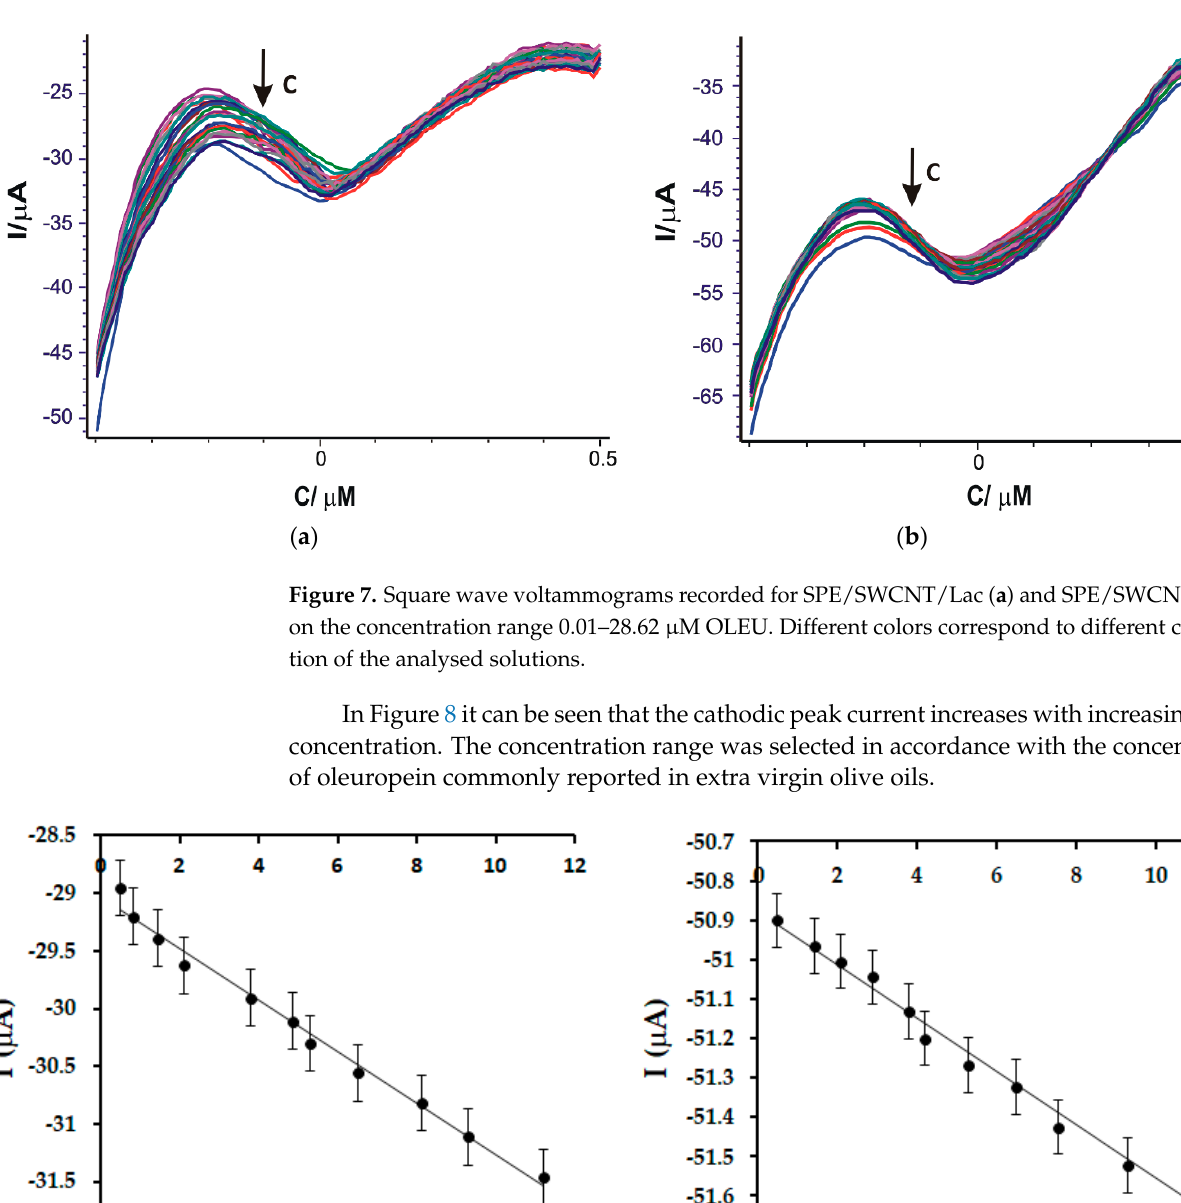
Table 3. Linear dependence equation, R 2 , LOD and LOQ for the two modified electrodes. Biosensor